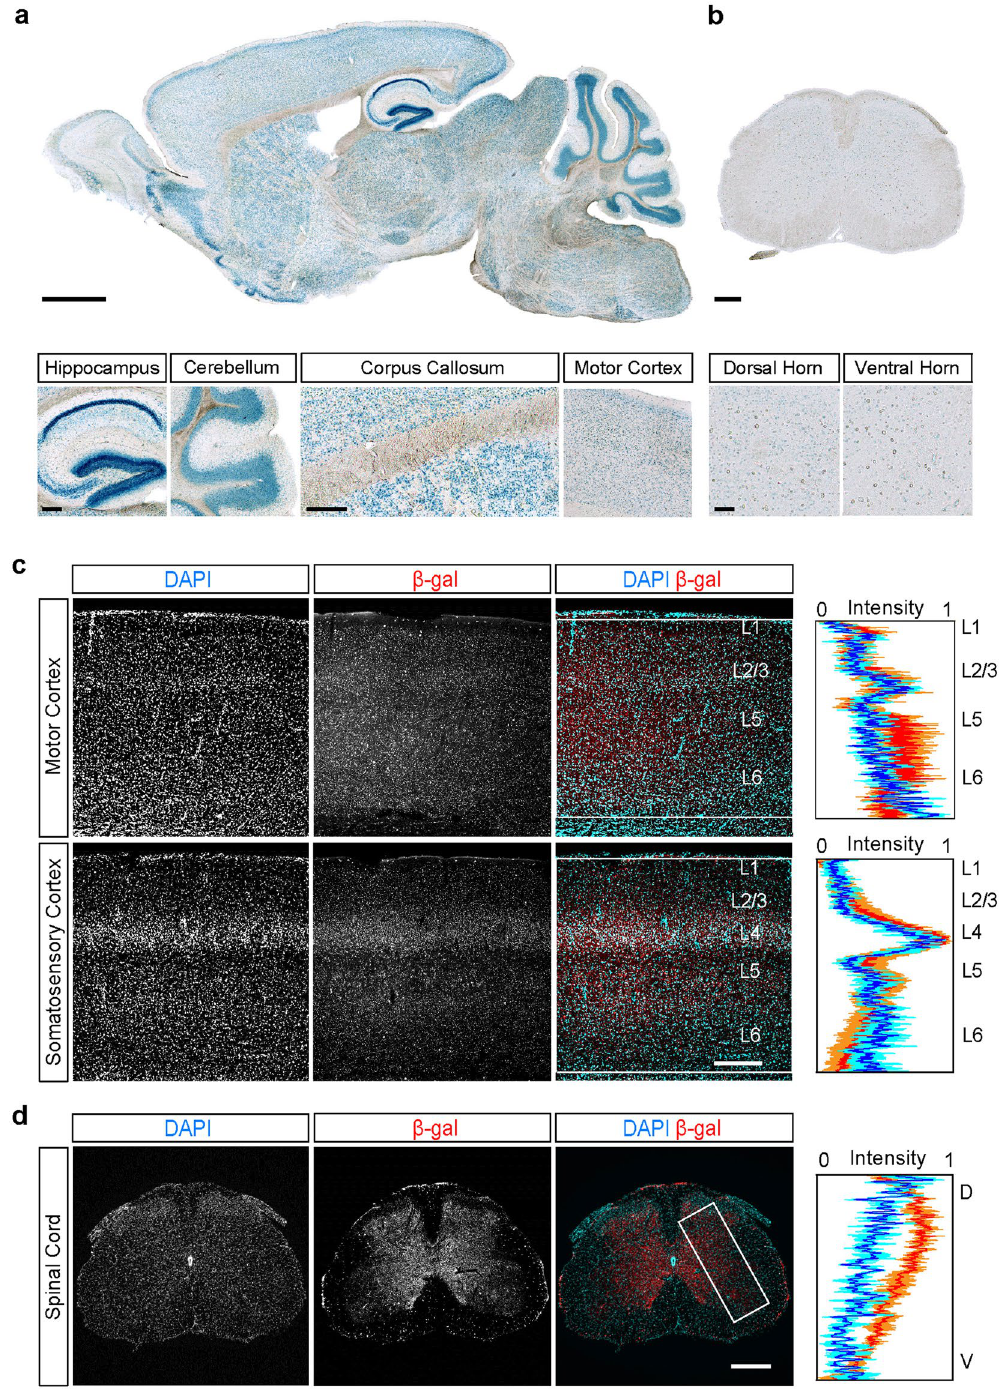
Figure 1. The distribution of C9orf72 promoter activity follows overall cellular density in the central nervous system. ( a ) The overall distribution of C9orf72 promoter activity in a parasagittal brain section from a C9orf72 LacZ/ + mouse revealed using X-gal staining. C9orf72 promoter activity was high in brain regions with high cell density (dentate gyrus of the hippocampus, cerebellar granule cell layer, two left panels), low in regions with low cell density (cerebellar molecular cell layer and corpus callosum, middle panels), and medium in motor cortex (rightmost panel). ( b ) The overall distribution of C9orf72 promoter activity in a coronal section of the lumbar spinal cord. X-gal staining was seen in both the dorsal and ventral horns (left and right panels) ( c ) Representative images showing the distribution of immunofluorescence staining for β -gal in primary motor (top) and somatosensory (bottom) cortex of C9orf72 LacZ/ + mice concurrently labelled with the nuclear stain, DAPI. The intensities of the β -gal (red) and DAPI (blue) signals were summed along the horizontal axis in the region indicated by the white boxes (n = 3 mice) and the intensity values plotted (mean ± SEM). ( d ) A similar analysis was performed for lumber spinal cord ( n = 3 mice). Scale bars: ( a ) 1 mm, insets 100 µ m, ( b ) 200 µ m, insets 100 µ m and (c,d) 300 µ